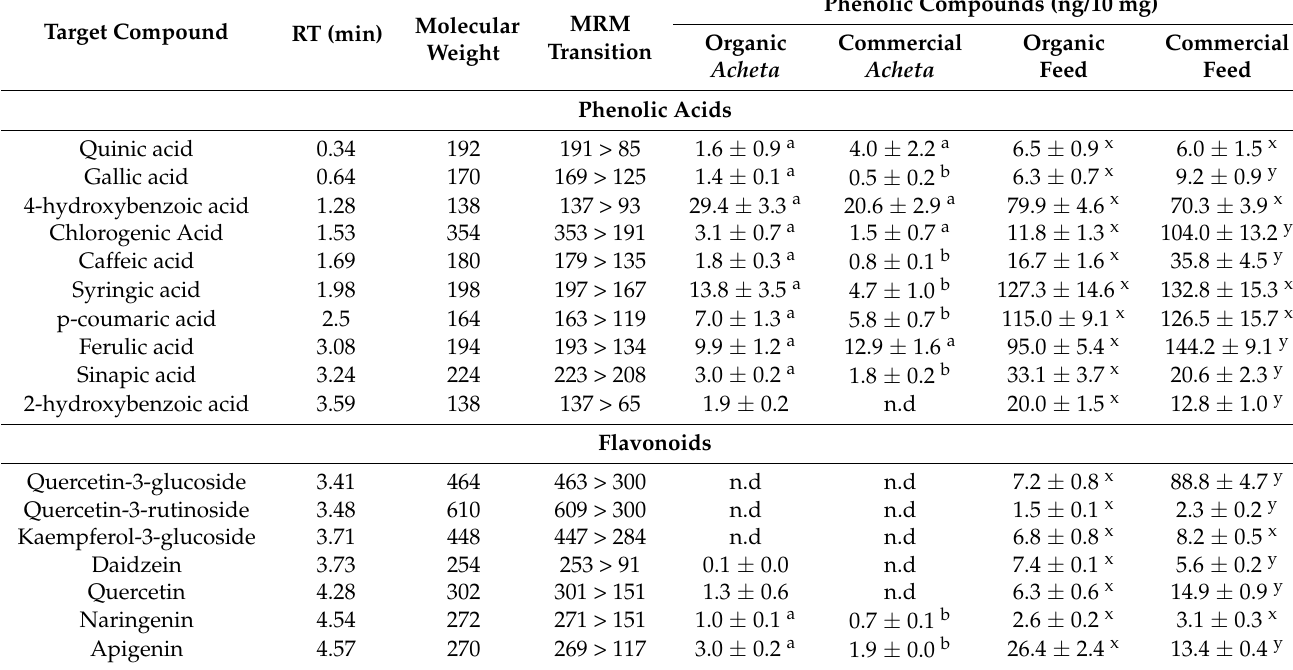
Table 2. Characterization of targeted phenolic compounds in A. domesticus and feed extracts by liquid chromatography coupled with electrospray-ionization triple quadrupole mass spectrometry (LC-ESI-QqQ-MS/MS).